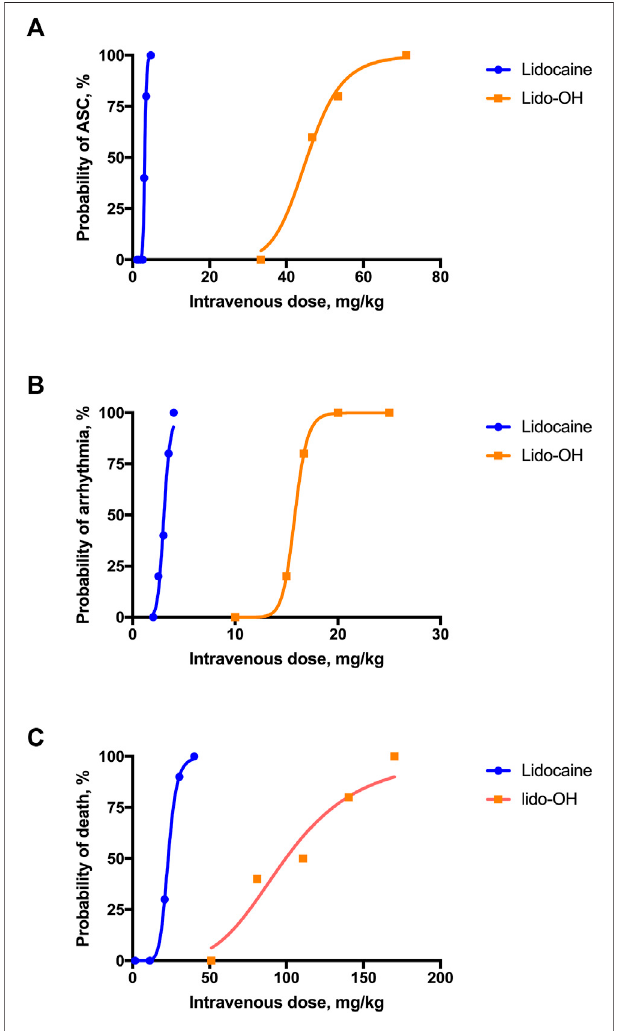
FIGURE 5 | Systemic toxicities were produced by single intravenous injection of lidocaine or lido-OH. Dose-toxicities relationships were evaluated inalteredstateofconsciousness (A) , n (cid:1) 10),arrhythmia (B) , n (cid:1) 5),anddeath (C) , n (cid:1) 10). ASC: altered state of consciousness.